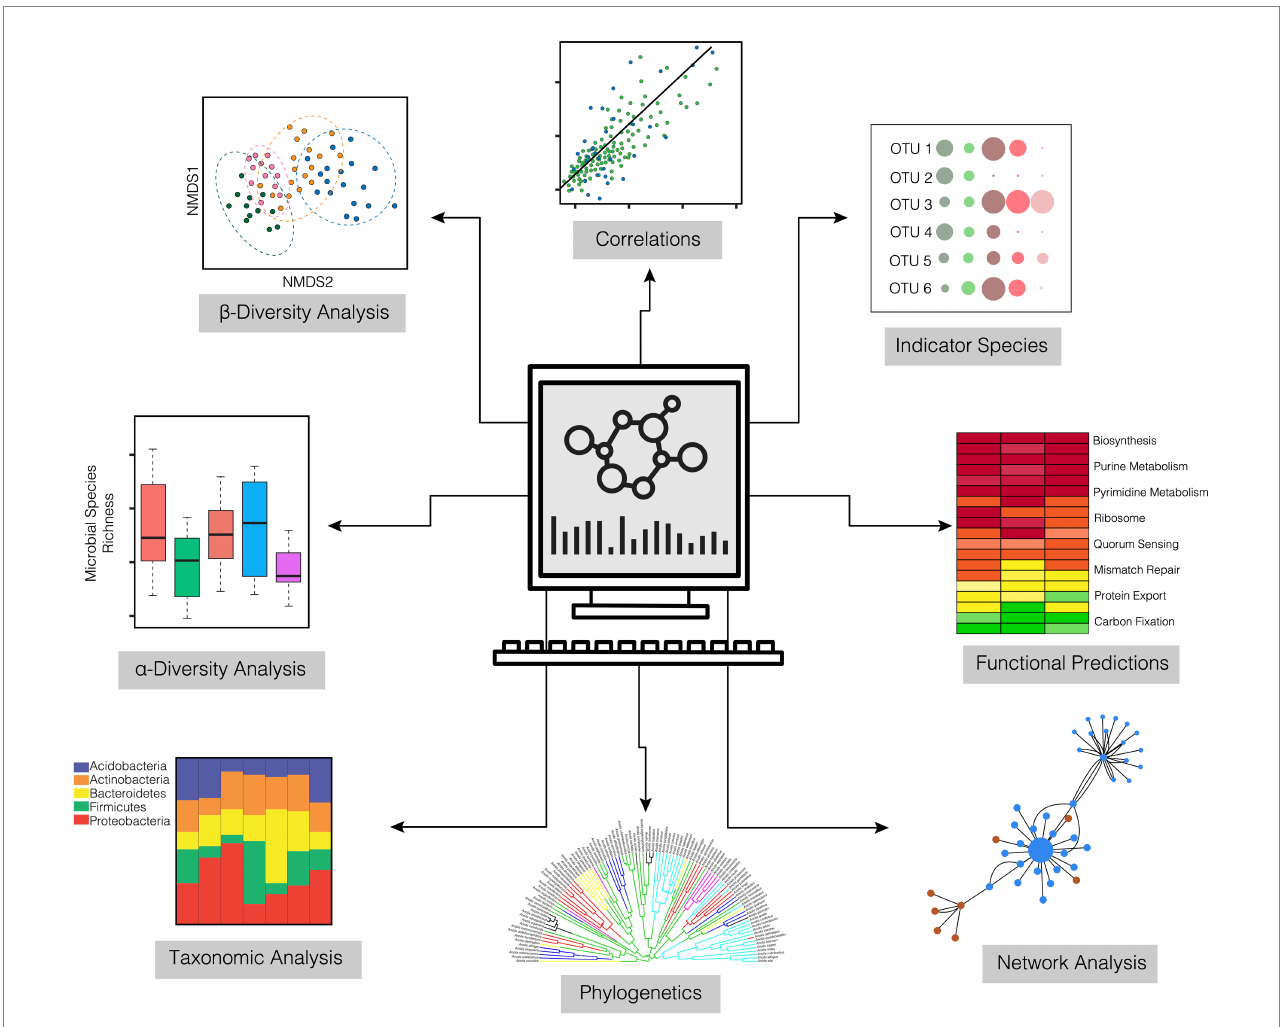
FIGURE 4 Downstream analyses for characterizing the abundance, diversity, and composition of coral microbiomes derived from 16S amplicon